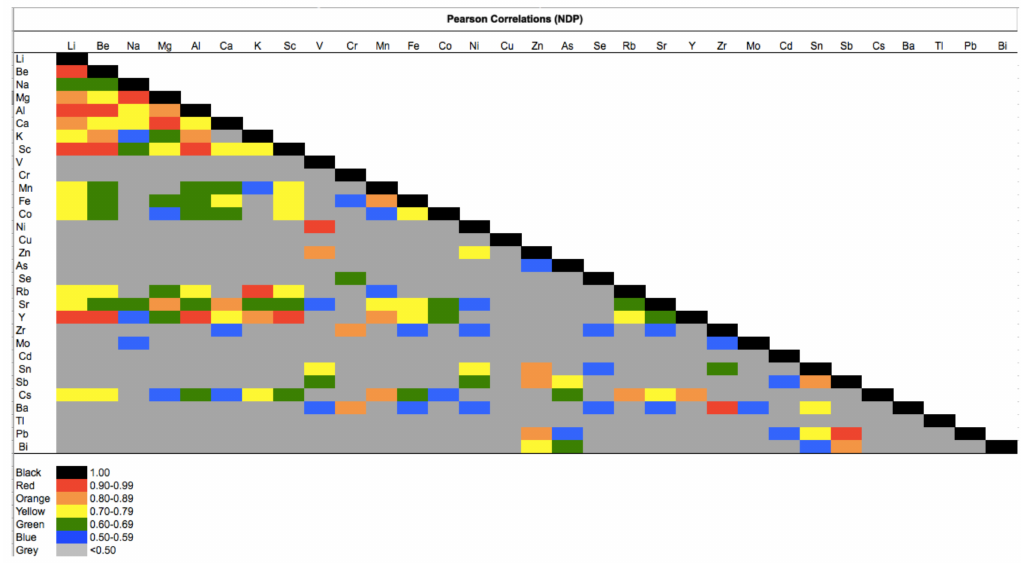
Figure 3. ( A ) Pearson correlation analysis of 31 selected metals collected during FDP; ( B ) Pearson correlation analysis of 31 selected metals collected during NDP.